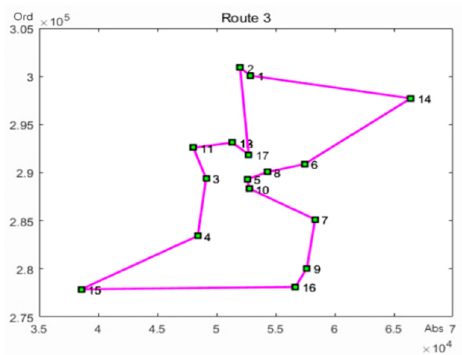
Figure 3. Delivery order of second courier.